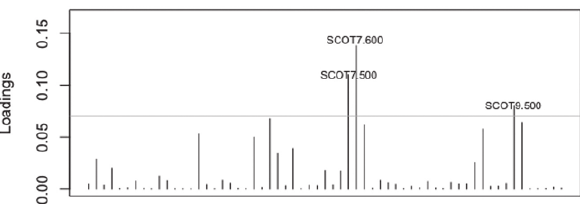
Figure 5. LDA loading of SCoT loci showing important loci of the first LDA axis.